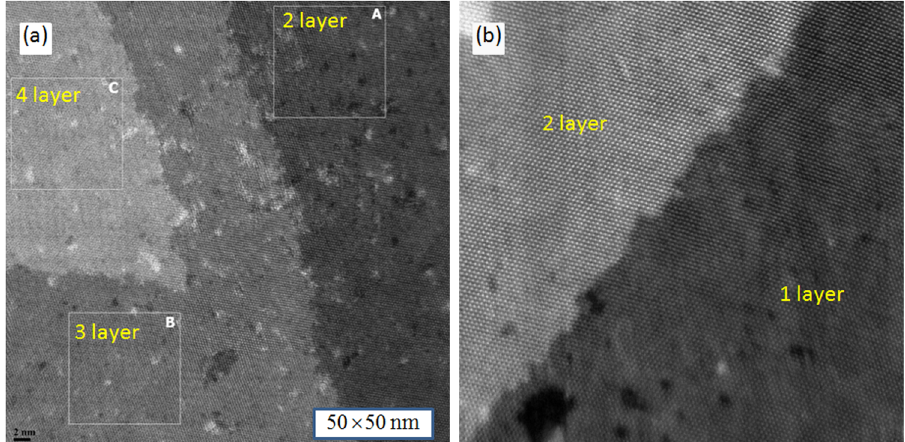
Fig. 2 STEM image of a thin layer sample of 1T-TaS 2 including several layers. STEM captures images based on information obtained from scattered electrons, and thus a domain with a lot of scatterers is brighter. Thus, the magnitude of the brightness corresponds to the number of layers. a The darkest domain (right side of fi gure) is a bi-layer. The brightest domain (upper left side of fi gure) has four layers. In addition, the intermediate domain is a tri-layer. b The brightest domain has two layers, the darkest domain has one